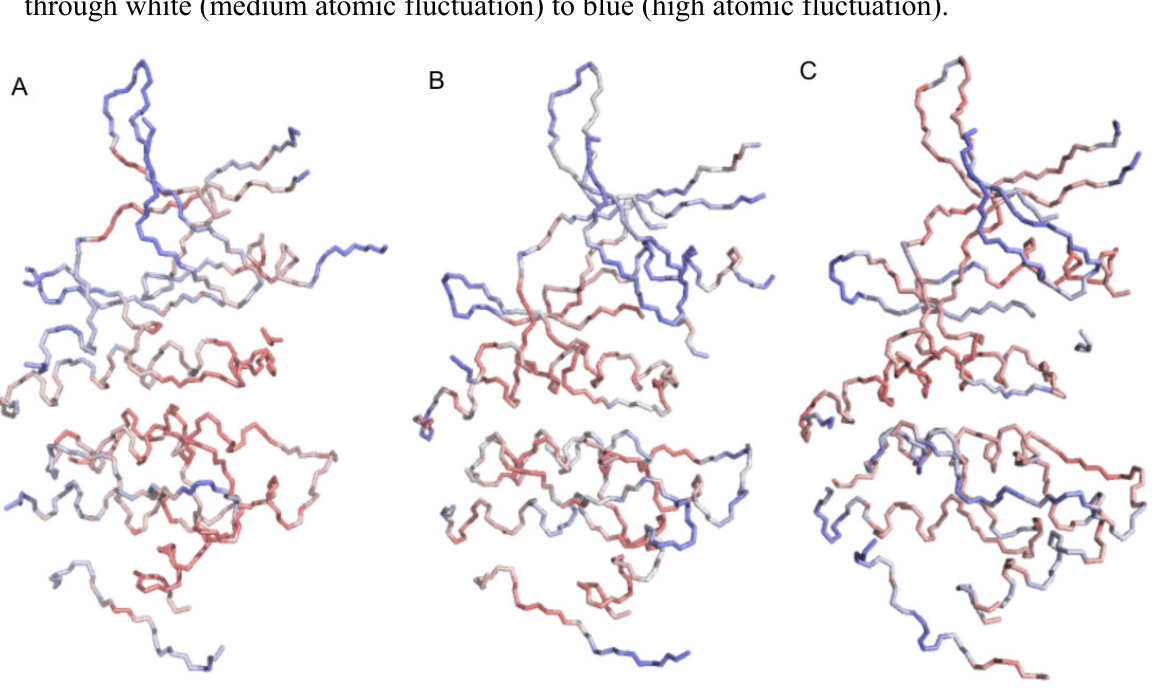
Figure 11. Atomic fluctuations associated with the eigenvector likely to result from the ASP method mapped onto the mask atoms (as detailed in Tables 1 and 2) for ( a ) GSK3 β ; ( b ) CDK5; and ( c ) CDK5/p25. Colour gradient ramps from red (low atomic fluctuation) through white (medium atomic fluctuation) to blue (high atomic